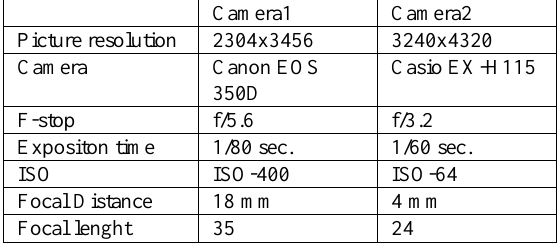
Tab.1 Technical characteristics of the used cameras Eight photos were taken with the Camera1 and ten photos with